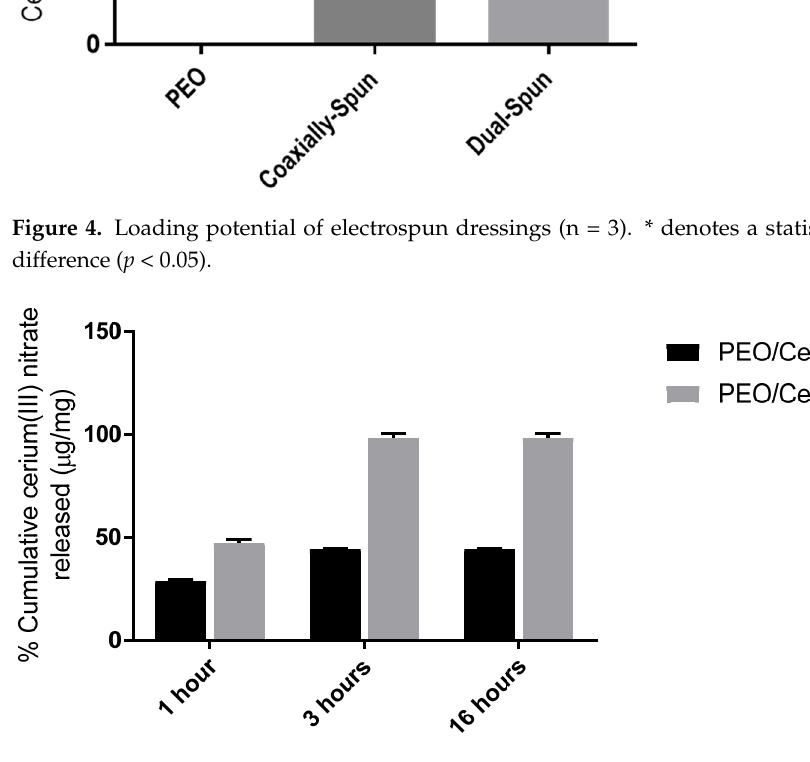
Figure 4. Loading potential of electrospun dressings (n = 3). * denotes a statistically significant difference ( p < 0.05).